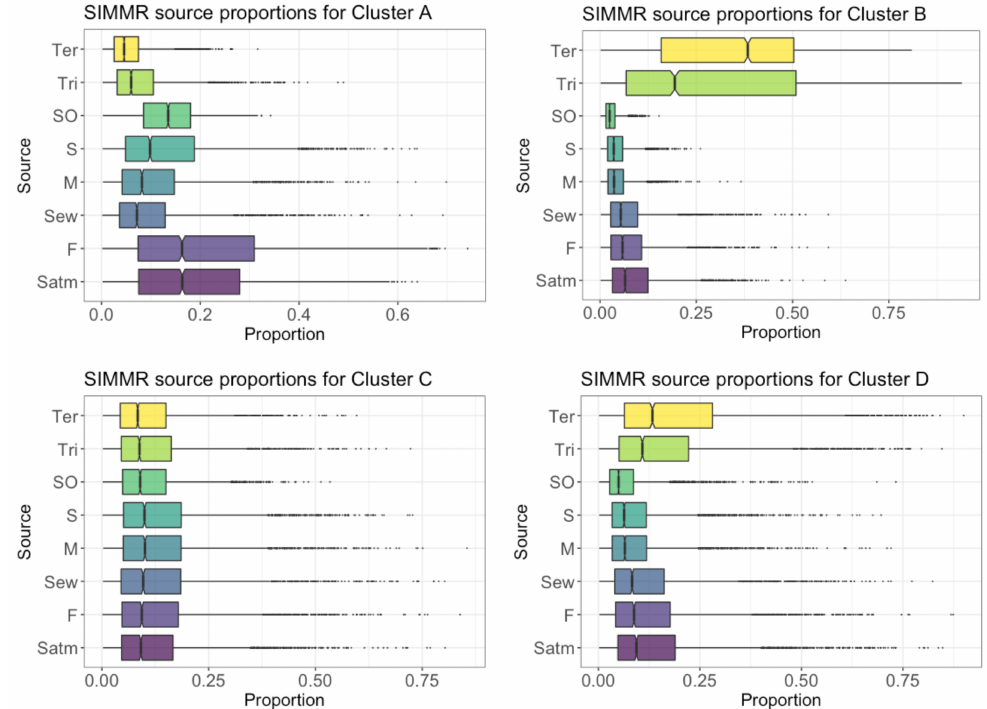
Figure 10. Bayesian isotope mixing model corresponding to sulfate for clusters A, B, C, and D. The considered sources are the same as the biplots (Figure 9): (SO) sulfide oxidation; (M) manure; (S) soil; (Satm) atmosphere deposition (F) fertilizers; (S) sewage; (Tri) Triassic evapo-rites; and (Ter) Tertiary